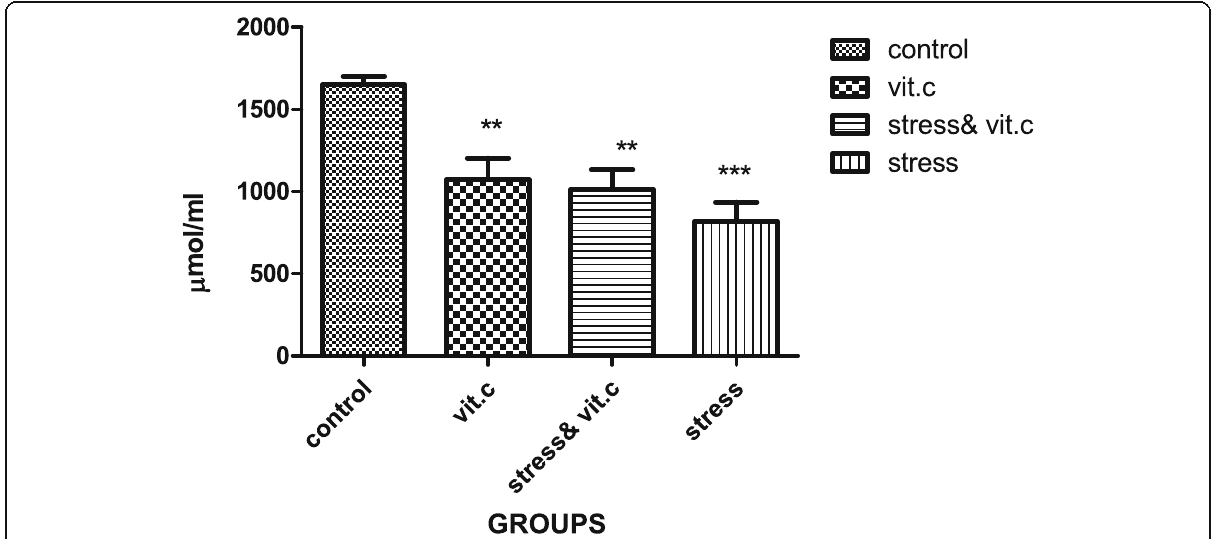
Fig. 7 Effect of chronic variable stress with vitamin C supplementation on serum level of catalase in Wistar rats. ** p < 0.001; *** p < 0.0001 when compared to